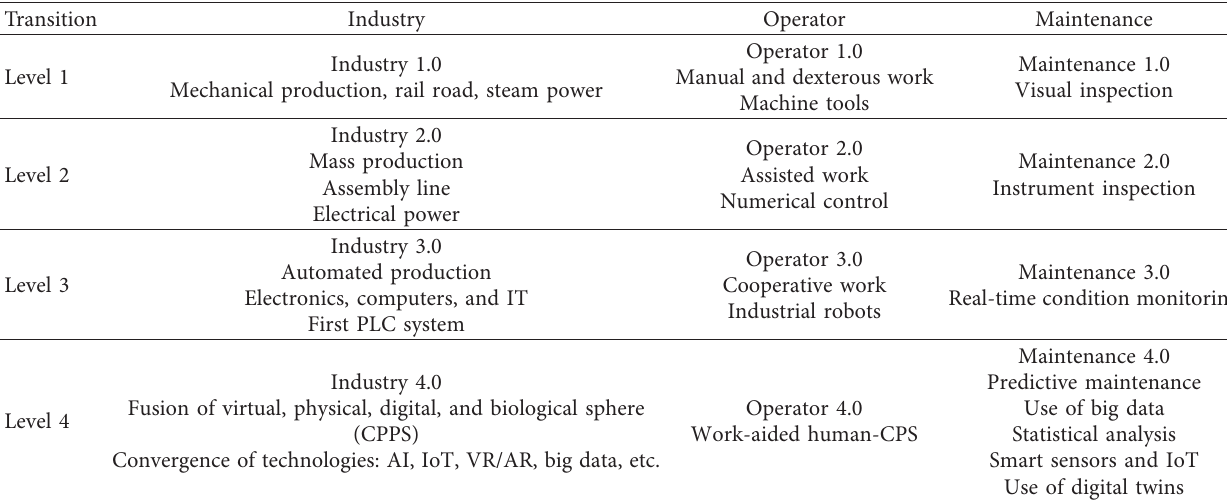
Table 1: Transition in industry, operator, and